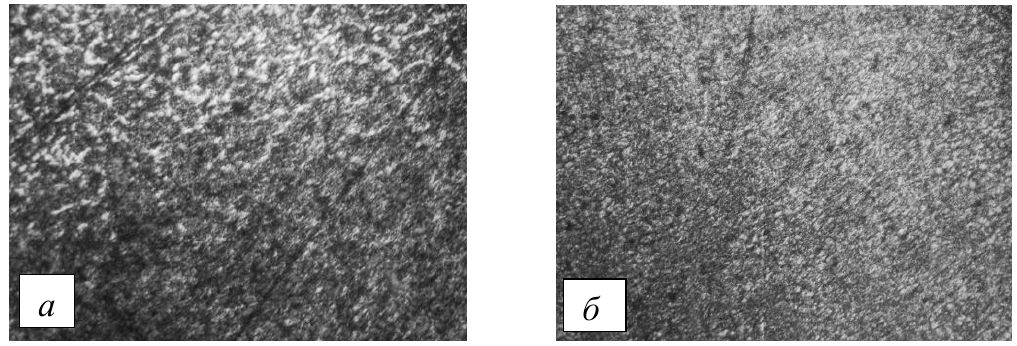
Fig.2. Microstructures of the deposited coating system Fe-Cr-B4C-Mo-C - 2% chromium, 1% boron carbide, 0.5% molybdenum and 0.4% carbon, thickness up to 0.5 mm (x150)